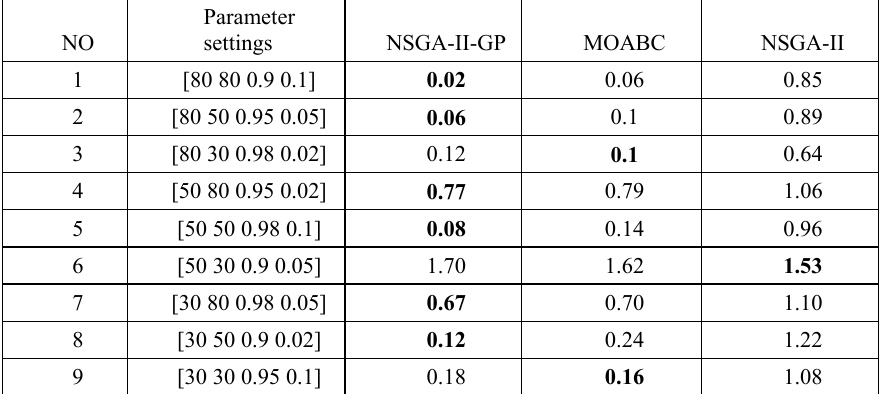
Table 2. Comparison of MIGD values of three algorithms with different parameters.